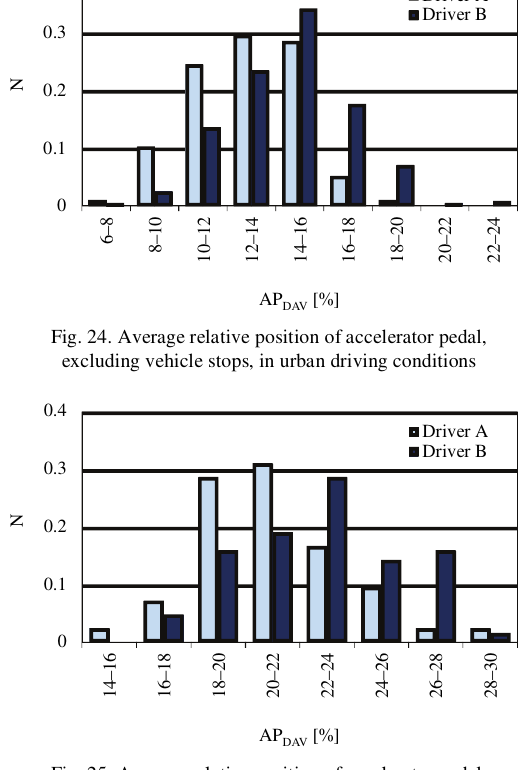
Fig. 29. Average relative position of accelerator pedal, excluding vehicle stops and zero position, in extra-urban driving conditions